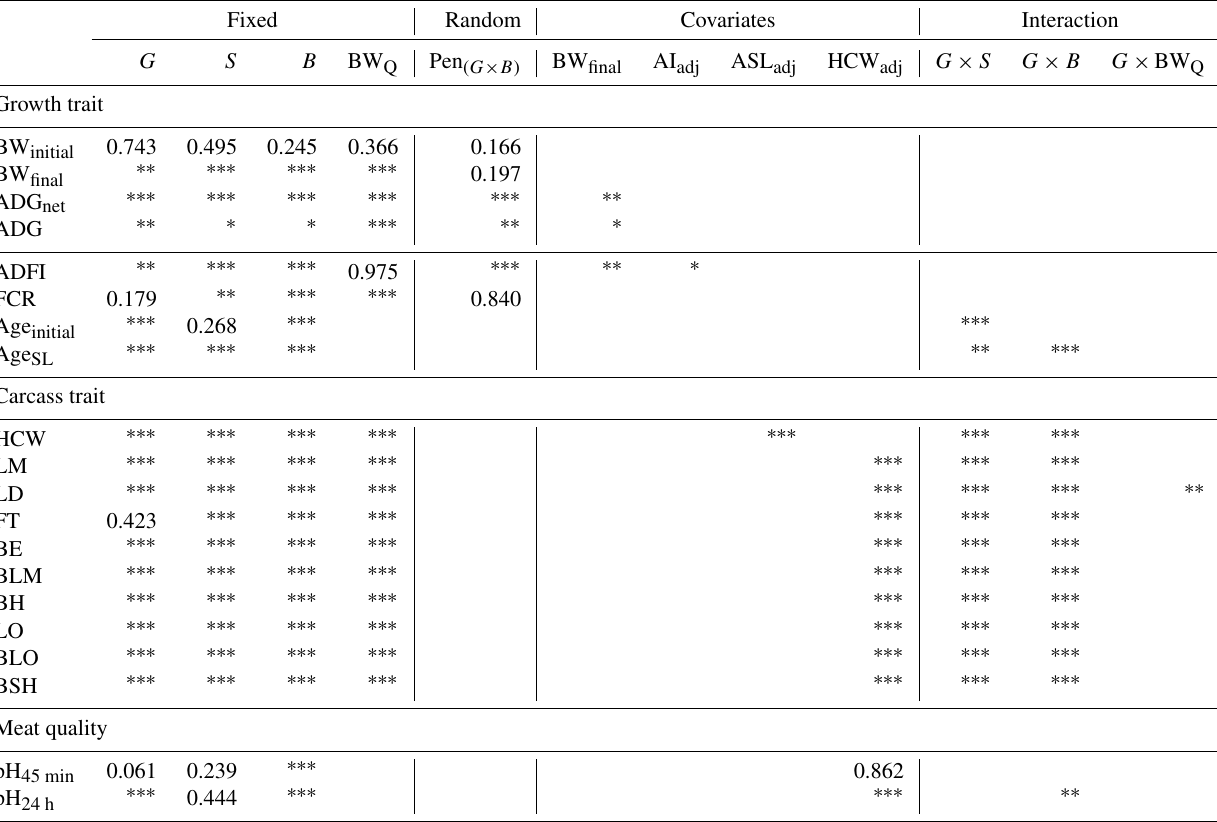
Table 2. Final models with the p values of fixed effects, random effects, covariates and interactions for growth traits, carcass traits and meat quality. Fixed Random Covariates Interaction G S B BW Q Pen ( G × B ) BW final AI adj ASL adj HCW adj G × S G × B G × BW Q Growth